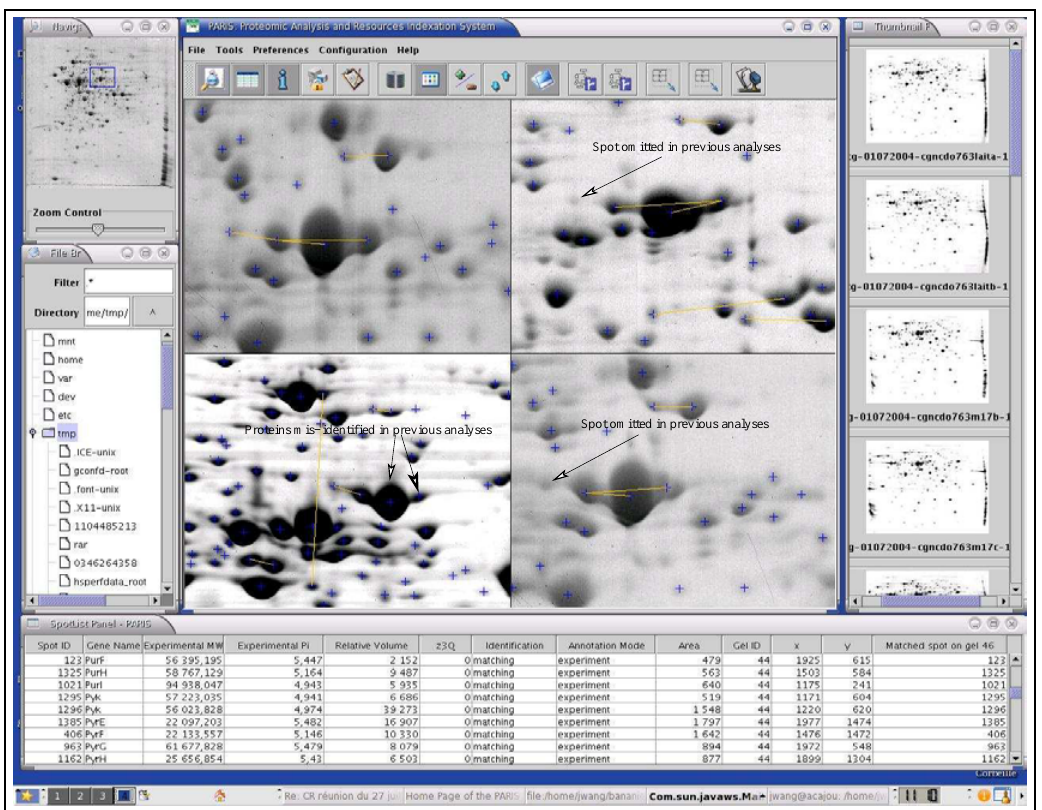
Figure 6: Post-planned analysis of the L. lactis polyacrylamide gel electrophoresis data with PARIS. In this example, we used new data to re-analyze the previously acquired ones and found some important spots omitted and/or proteins mis-identified in previous analyses. The relation- ships illustrated here on the gels correspond to protein iso-form relationship and the found omitted spots and mis-identified proteins are related to the pyk gene